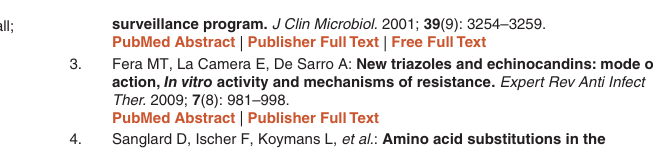
Data availability figshare: Tubulin deacetylation and rHos2 protein blots, doi: 10.6084/m9.figshare.841666 35 figshare: Sirtuin assay of purified Hos2 preparations using resvera- trol: UPDATE 1, doi: 10.6084/m9.figshare.1031579 36 figshare: Deacetylase activities of rHos2 and dose response curves of rHos2 inhibition by standard HDAC inhibitors: UPDATE 1, doi: 10.6084/m9.figshare.1031581